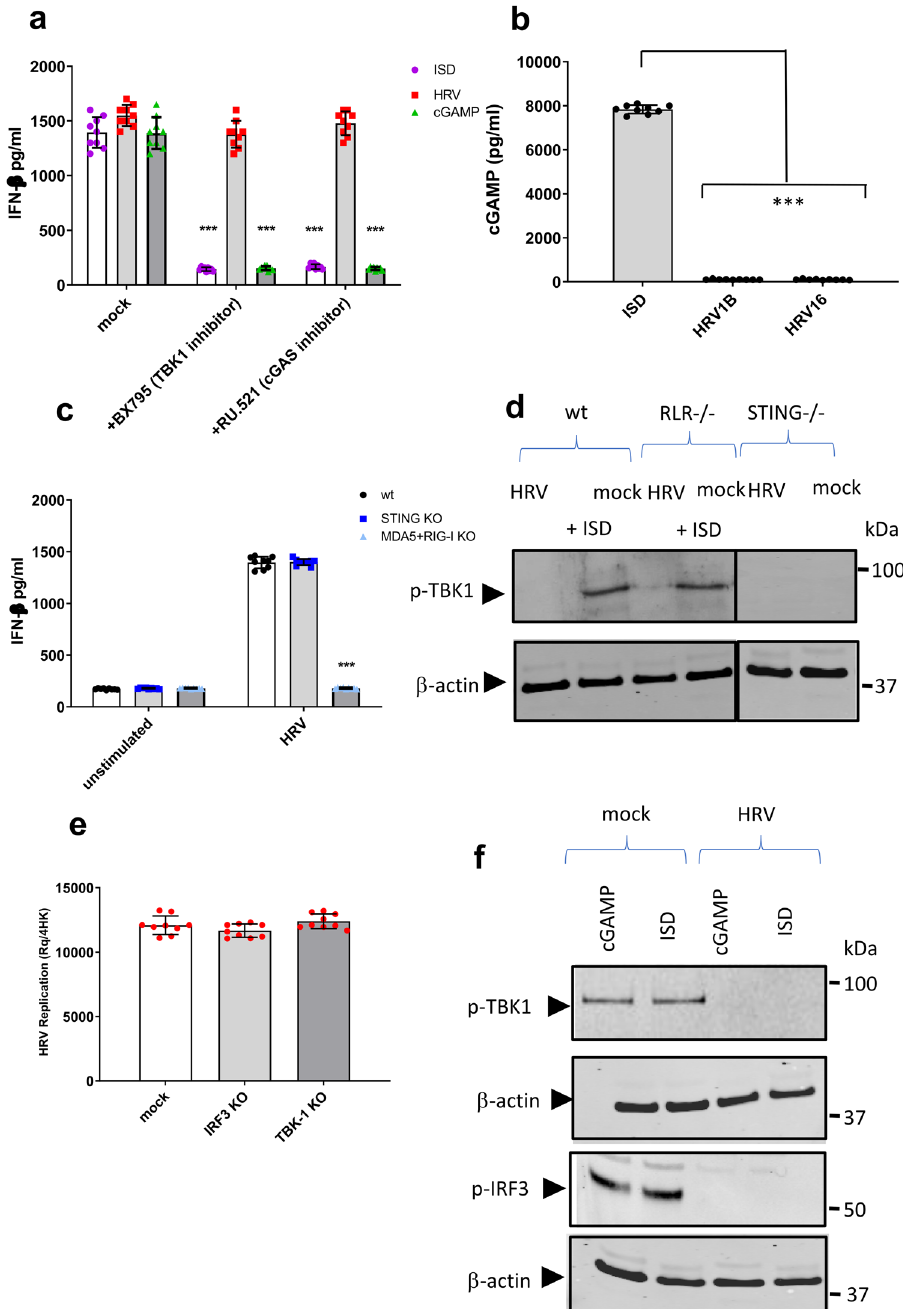
Fig. 2 STING role in HRV infection is independent of cGAS/STING canonical pathway. IFN- β production in BEAS-2B cells infected with HRV-A1B in the presence of inhibitors BX795 (1 µ M) and RU.521 (500 nM) for 24 h measured by ELISA. Data are means ± SD ( n = 3, from three independent experiments). *** p < 0.001 indicate statistically signi fi cant ( a ). cGAMP levels in bronchial epithelial cells infected with different strains of HRV (MOI 1) was measured by ELISA. Data are means ± SD ( n = 3, from three independent experiments). *** p < 0.001 indicate statistically signi fi cant ( b ). BEAS-2B (WT), BEAS-2B STING-de fi cient cells (STING KO) and BEAS-2B de fi cient cells for MDA5 and RIG-I (MDA5 + RIG-I KO) were infected with HRV-A1B. IFN- β levels in the supernatant after 24 h were measured by ELISA. The data represent the mean of three independent experiments ± SD ( n = 3) yielding consistent results. Statistical signi fi cance between unstimulated and virus-infected conditions was assessed by unpaired student ’ s t -test ** p < 0.005 and *** p < 0.001 ( c ). The presence of p-TBK1 in lysates from BEAS-2B wildtype, STING KO or RLR KO BEAS-2Bs infected with HRV-A1B (MOI 1) for 1 h or exposed to 1 µ g ISDs was detected via Western blotting ( n = 3 independent experiments, representative western blot shown) ( d ). IRF3 or TBK1 was also knocked out in bronchial epithelial cells to determine whether it had an effect on HRV inhibition. Data are means ± SD ( n = 3, from three independent experiments) ( e ). Bronchial epithelial cells infected with HRV-A1B (MOI 1) as well as mock (uninfected) cells were stimulated with either 1 µ g ISD or 5 µ g cGAMP, after 24 h cells were lysed and the presence of p-TBK1 and p-IRF3 were detected via western blotting ( n = 3 independent experiments, representative western blot shown). Data are means ± SD ( n = 3), *** p < 0.001 ( f ).